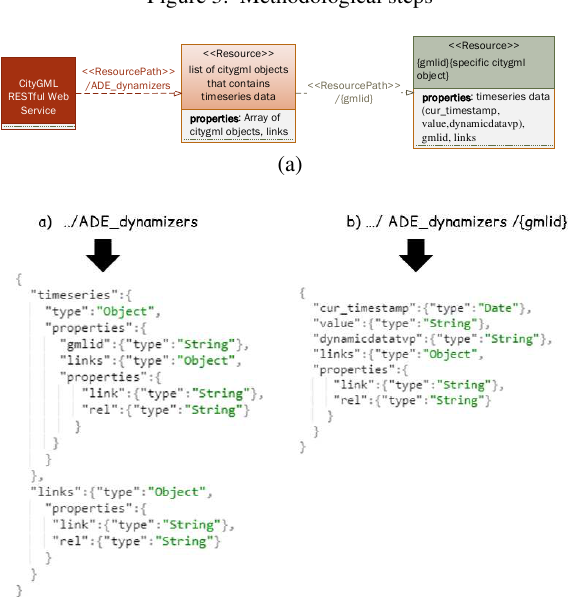
Figure 3. Methodological steps